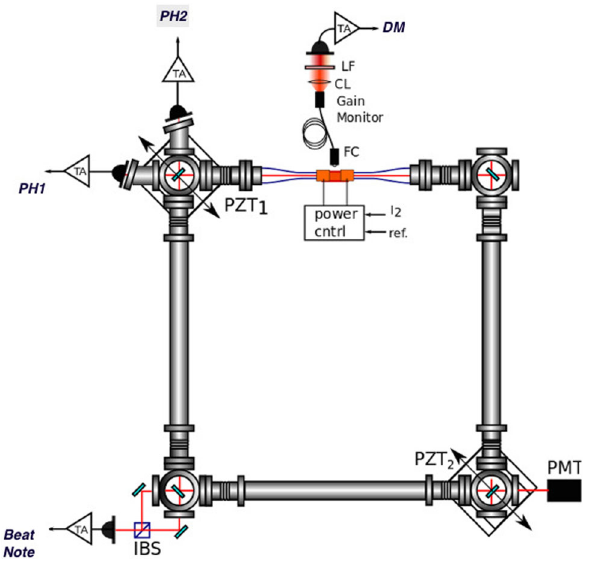
Fig. 1 Typical scheme of RLG with a square ring cavity. Photodiodes used to measure the beat note, necessary to evaluate the ω m , the two mono-beams ( PH 1 and PH 2) and the gain monitor ( DM ) are shown. PMT indicates an additional photodetector not used for the purposes of the present paper. Note that the signal produced by the photodiode PH 1 is used also in a feedback loop to control the power of the laser